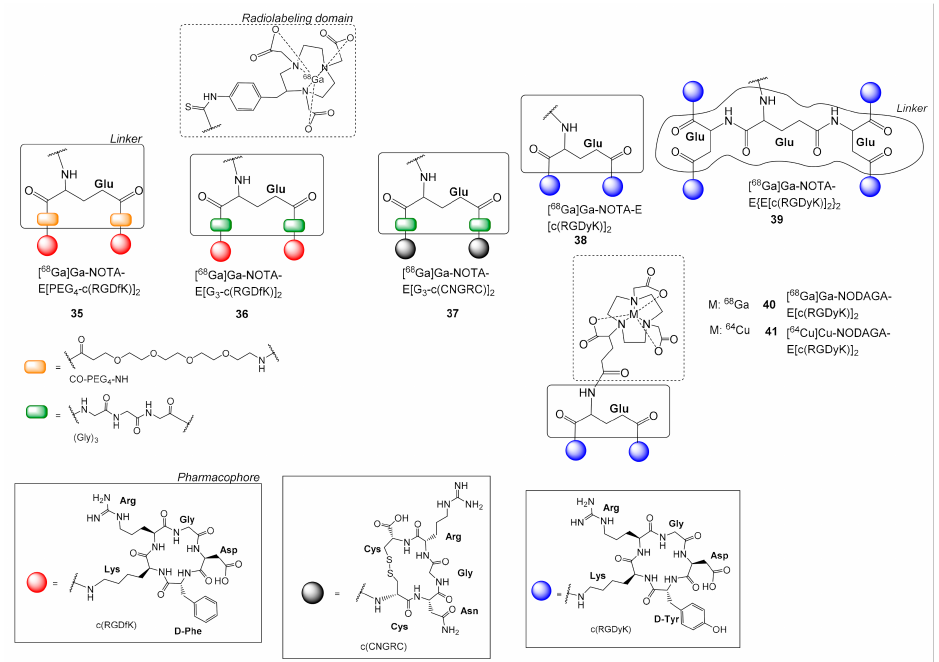
Figure 11. Chemical structures of the dimeric radioligands [ 68 Ga]Ga-NOTA-E[PEG 4 -c(RGDfK)] 2 35 , [ 68 Ga]Ga-NOTA-E[G 3 -c(RGDfK)] 2 36 and [ 68 Ga]Ga-NOTA-E[G 3 -c(CNGRC)] 2 37 , [ 68 Ga]Ga-NOTA- E[c(RGDyK)] 2 38 , [ 68 Ga]Ga-NOTA-E{E[c(RGDyK)] 2 } 2 39 , [ 68 Ga]Ga-NODAGA-E[c(RGDyK)] 2 40 and [ 64 Cu]Ga-NODAGA-E[c(RGDyK)] 2